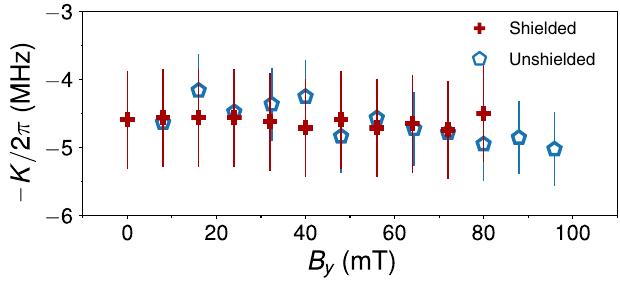
FIG. 13. Measured nonlinear coefficients K ð 5 Þ (shielded) and K ð 6 Þ (unshielded) versus in-plane field.